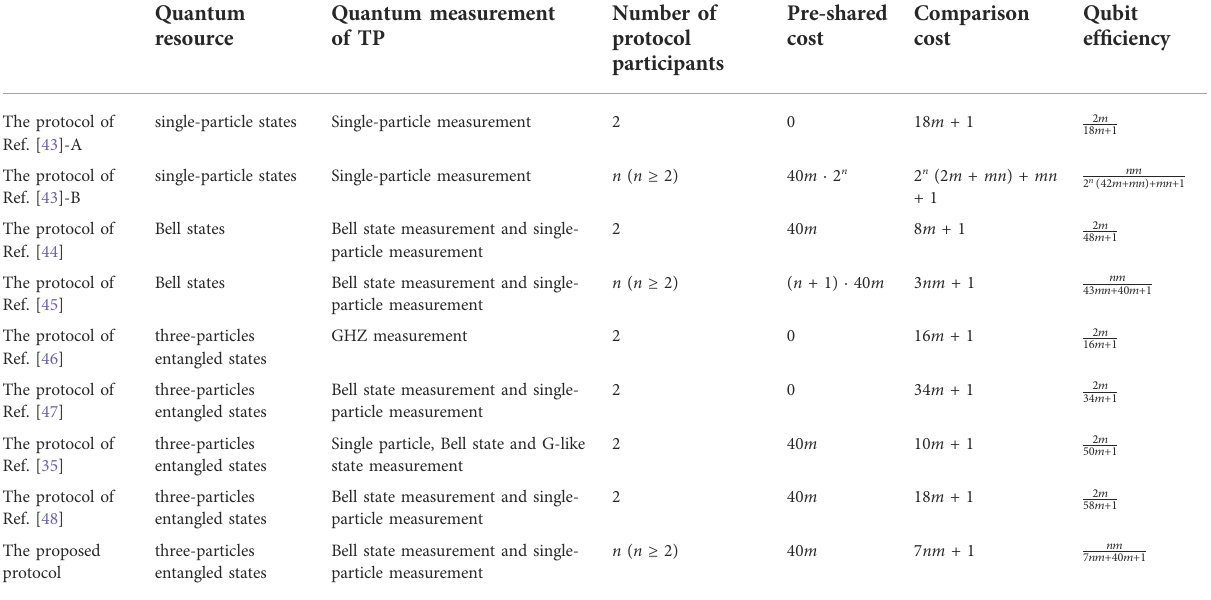
TABLE 1 The comparison of our protocol to the other